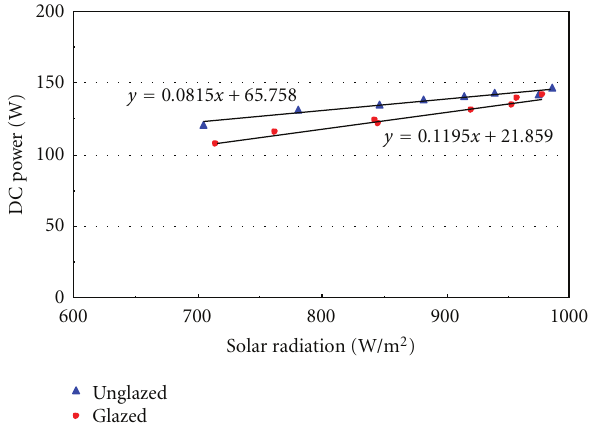
Figure 12: Electrical power of the glazed and unglazed PVT collectors as a function of solar radiation ( T i = 40 ◦ C).